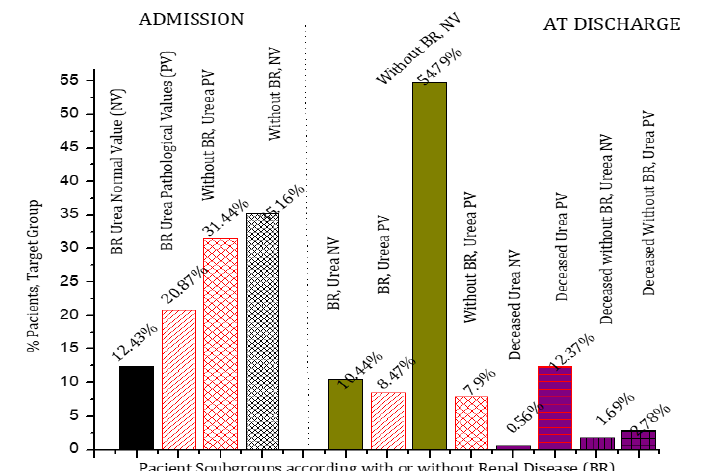
Figure 3. Comparative presentation of the number of patients (in percentages) at admission and at discharge, by subgroups: BR with uremia within normal limits, BR with uremia within pathological limits, FBR with uremia within normal limits, FBR with uremia within pathological limits and Deceased BR with uremia within normal limits, BR deceased with uremia within pathological limits, FBR deceased with uremia within normal limits, FBR deceased with uremia within pathological limits (BR = renal disease, FBR = without renal disease)